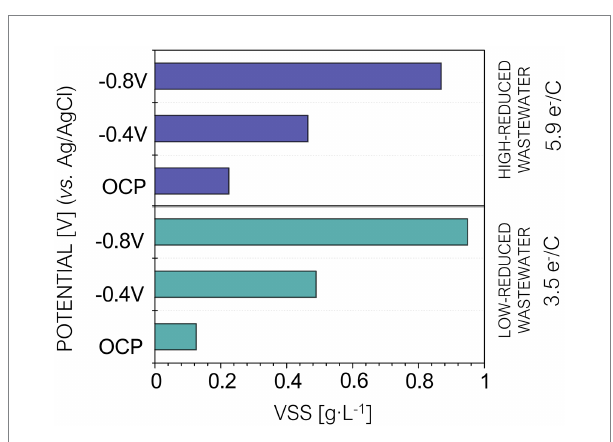
FIGURE 4 Volatile suspended solids (VVS) produced at the end of the experiment under open circuit potential (OCP), − 0.4 V and − 0.8 V. HRT = 5 days. Purple bars correspond to reactors fed with high- wastewater and blue bars corresponds to the reactors fed with low- reduced